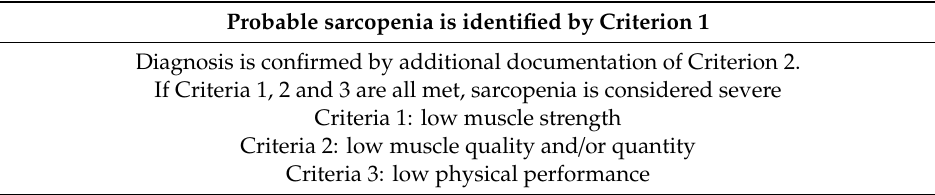
Table 1. 2018 definition of sarcopenia according to the EWGSOP